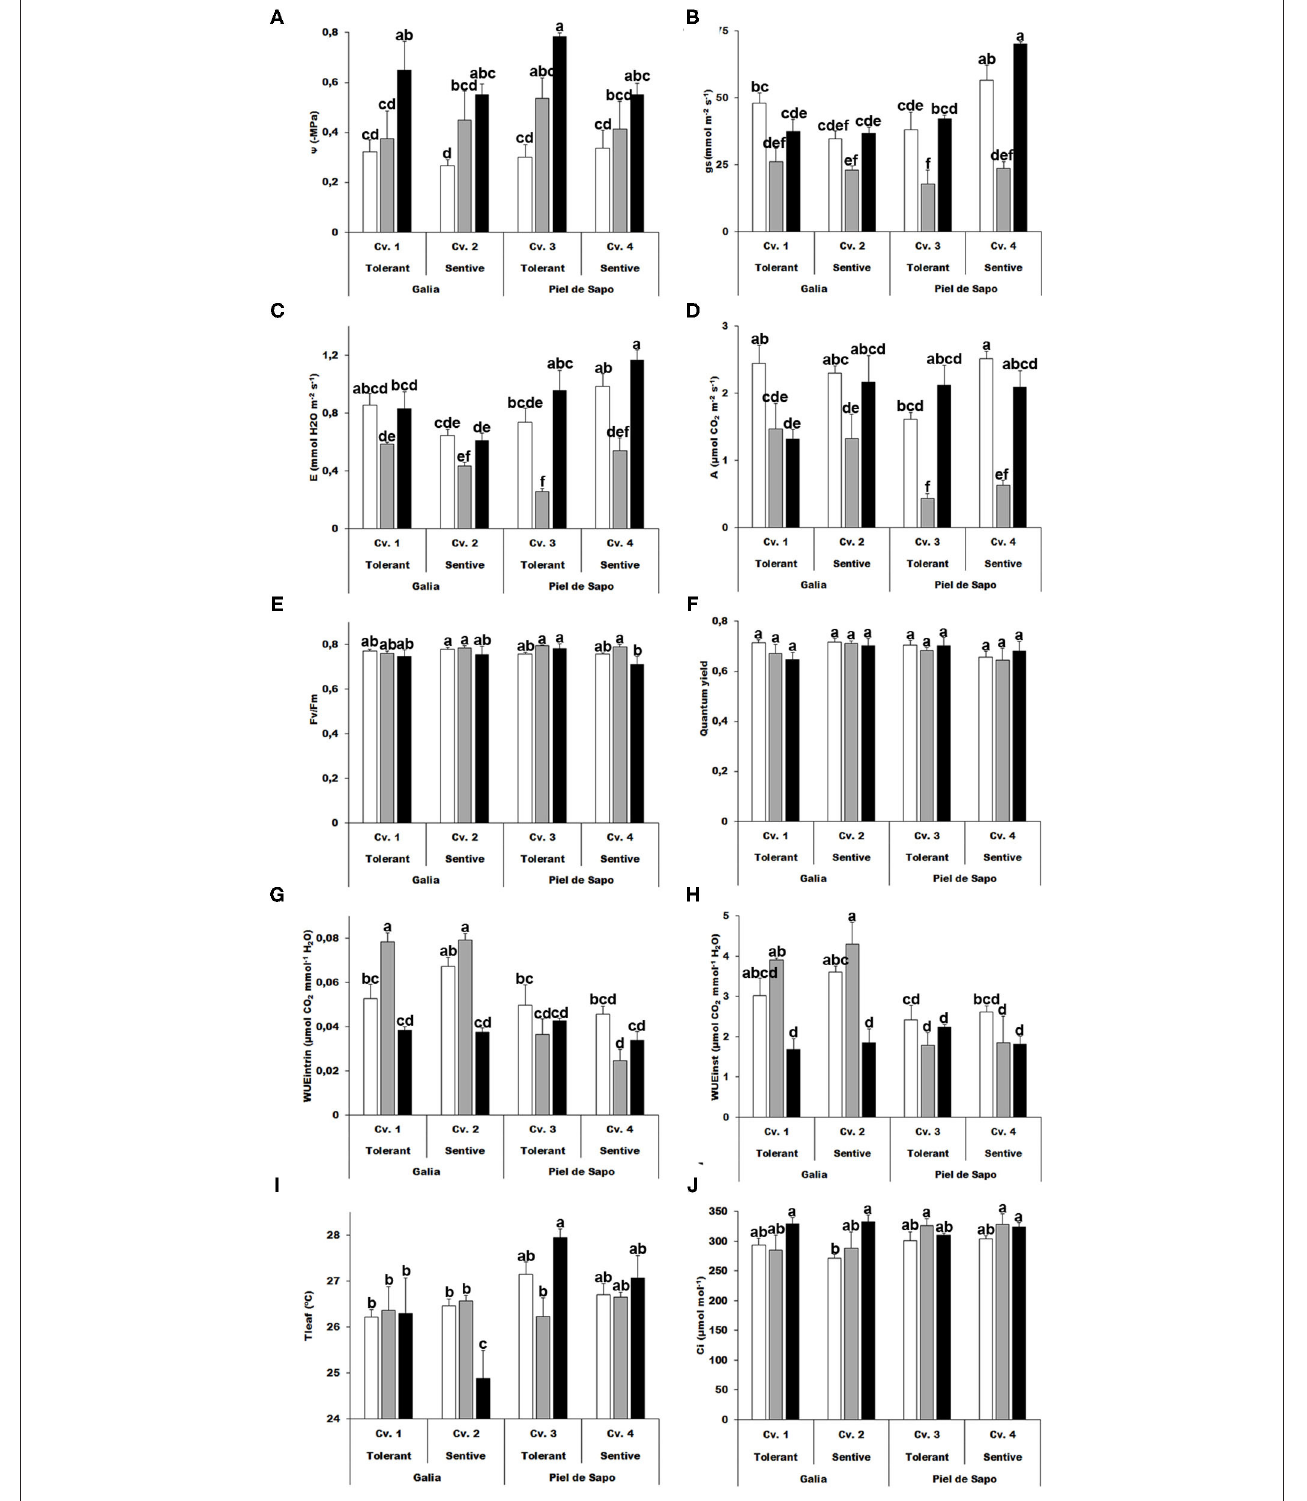
FIGURE 1 | Physiological measurements. Water potential ( 9 w) (A) ; stomatal conductance (gs) (B) ; transpiration (E) (C) ; Net photosynthesis (A) (D) ; Quantum efficiency of photosystem II (Fv/Fm) (E) ; Quantum yield (F) ; intrinsic water use efficiency (WUEintr) (G) ; instantaneous water use efficiency (WUEinst) (H) ; Leaf temperature (Tleaf) (I) and sub-stomatal CO 2 concentration (Ci) (J) of Galia tolerant genotype (Cv. 1), Galia sensitive genotype (Cv. 2), Piel de Sapo tolerant genotype (Cv. 3) or Piel de Sapo sensitive genotype (Cv. 4) under control (white bars), salt stress (gray bars) and drought stress (black bars) conditions. Data with different letters differ significantly ( p < 0.05), as determined by Duncan’s MRT test ( n = 5). Scale bars are the mean ± standard error (SE). Experiment was replicated with similar results.